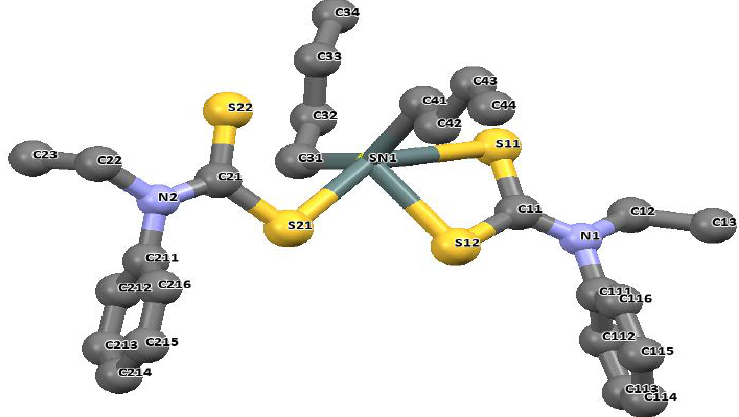
Figure 13. The molecular structure of dibutyltin(IV) complexes of N -ethyl- N -phenyldithiocarbamate [Bu 2 SnL 2 ]. (For clarity, H atoms were omitted). Redrawn from [89], with permission from Elsevier (Copyright 2018).